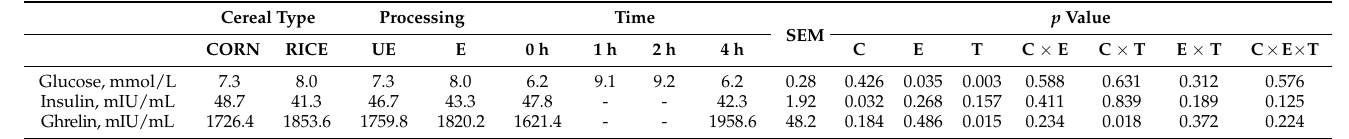
Table 5. Effects of cereal types and extrusion processing on levels of glucose, insulin, and ghrelin of weaned